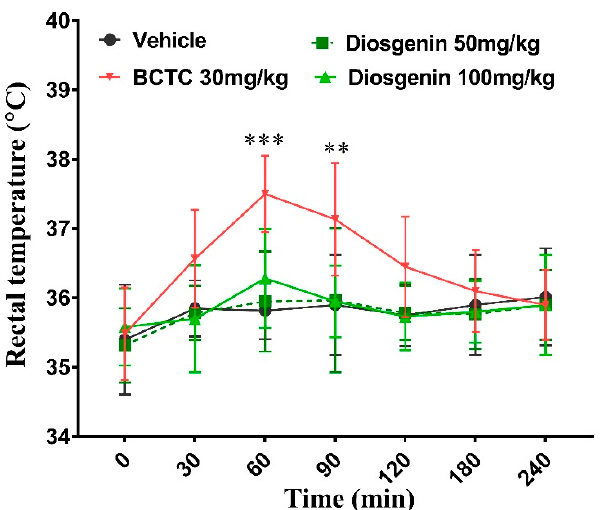
Figure 5. Oral administration diosgenin does not alter rectal temperature in normal mice. BCTC: N -(4-tertiarybutylphenyl)-4-(3-cholorphyridin-2-yl) tetrahydropyrazine-1(2H)-carbox-amide. Data are presented as mean ± standard error of mean (n = 6), ** p < 0.01 and *** p < 0.001, Bonferroni post hoc test following two-way RM ANOVA versus the vehicle group.